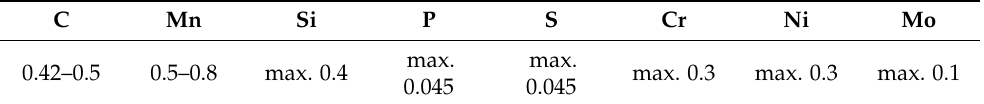
Table 1. Chemical composition of C45 steel, %.